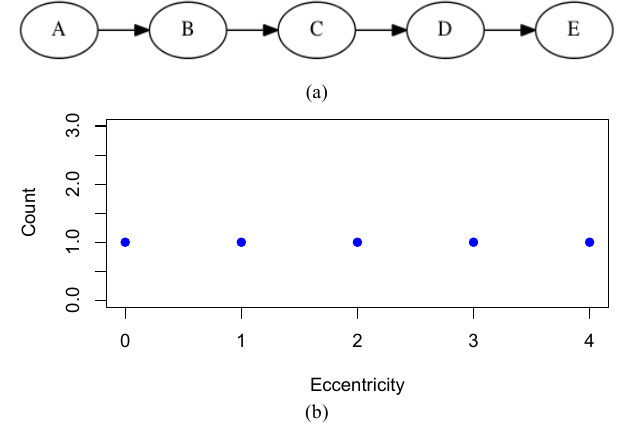
Fig. 2. Simple graph (a) and its corresponding eccentricity distribution (b).